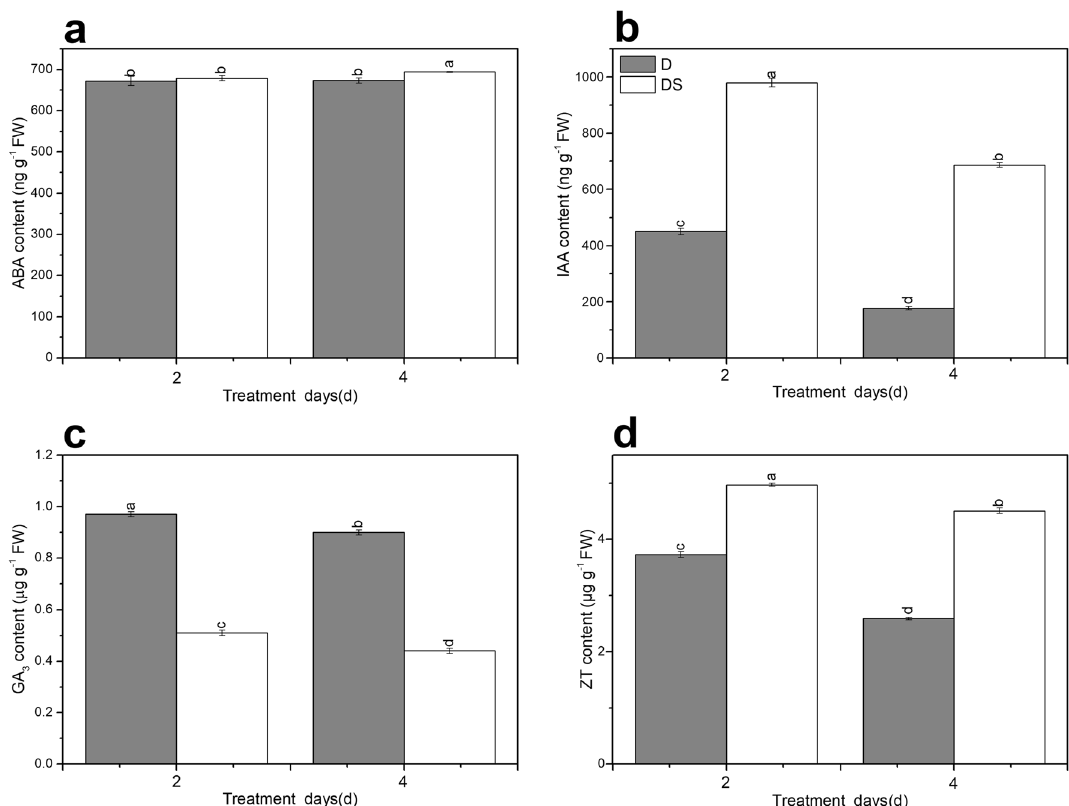
Figure 4. Uniconazole-induced endogenous hormones of ABA ( a ), IAA ( b ), GA 3 ( c ), ZT ( d ) levels under drought stress. All data are presented as the means ± standard errors (n = 3). D and DS expressed as treatments under drought stress and drought stress + uniconazole, respectively.